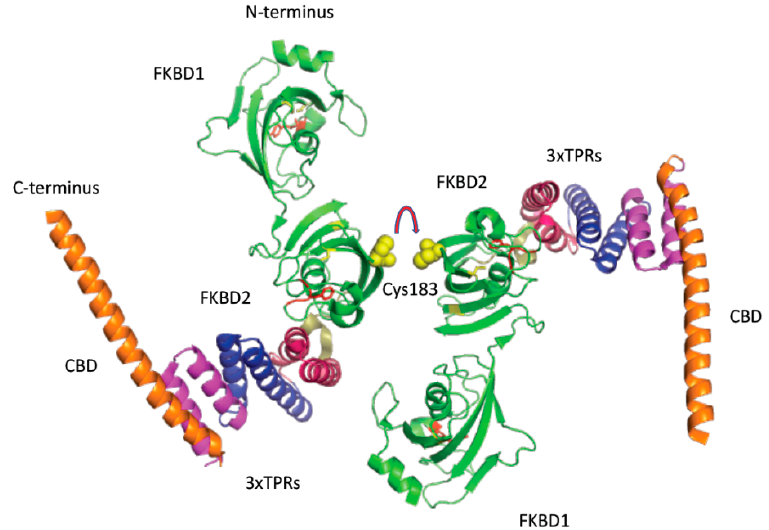
Figure 5. X-ray structure of the FKBP51 with its two FKBDs and the surface exposed Cys153 in FKBD2. FKBD1 and FKBD2 are in green with the AYG triads in red. Three consecutive tetratricopeptide repeats (TPRs) ( α -helical structures) are in deep red, blue and magenta, respectively. C-terminus forming a long α -helix is in orange. This helix may have some affinity to calmodulin and was named here calmodulin-binding domain (CBD).